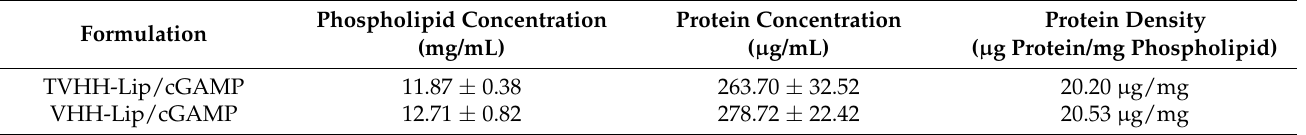
Table 2. The composition of nanobody targeted